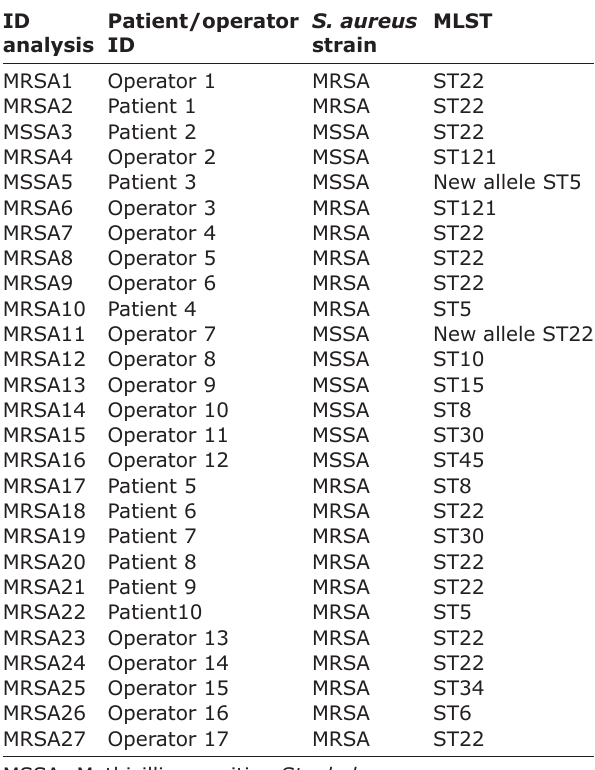
Table-1: S. aureus (MSSA or MRSA) strains and MLST profiles detected in patients and operators in the cardiac-surgical area of L. Sacco Hospital, Milan, from January to December